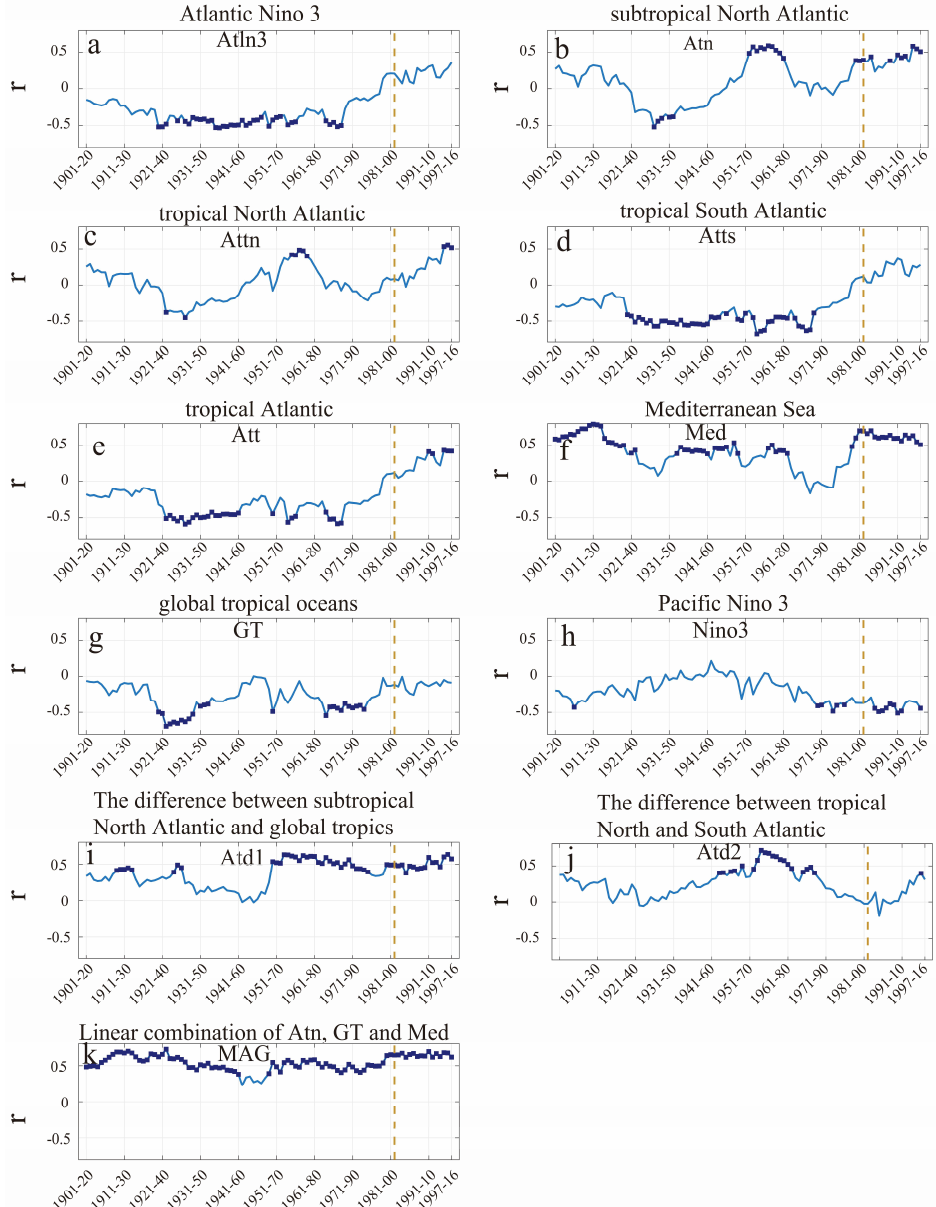
Figure 4. A 20 year sliding window running correlation between M–O SSTs and Sahel precipitation. Significant values ( p < 0.1) of the correlation in the 20 year windows are indicated with a dot symbol. Whether SST is responsible for the Sahelian precipitation trend changes at about 1999 as shown above is now further investigated. The anomalies of precipitation and SST indices between 1982 and 2016 are illustrated in Figure 5a. The time-dependent information flow (IF) from three of the SST indices to the Sahelian precipitation is shown in Figure 5b, and is computed from Equation (6) (see Data and Method). The IFs using the other 8 SST indices are not shown due to insignificant results. The broken lines indicate the evolution of the IF, and the solid lines indicate the statistically significant periods of the IF. Since 1999, all IFs of the three SST indices are negative. Both Med and Atd1 have some significant negative IFs between 2003 and 2014. At the same time, better performance appears on the MAG index with all significant negative IFs between 2003 and 2014. This implies that, within this period, the SST anomalies have contributed to the stabilizing or leveling off of the